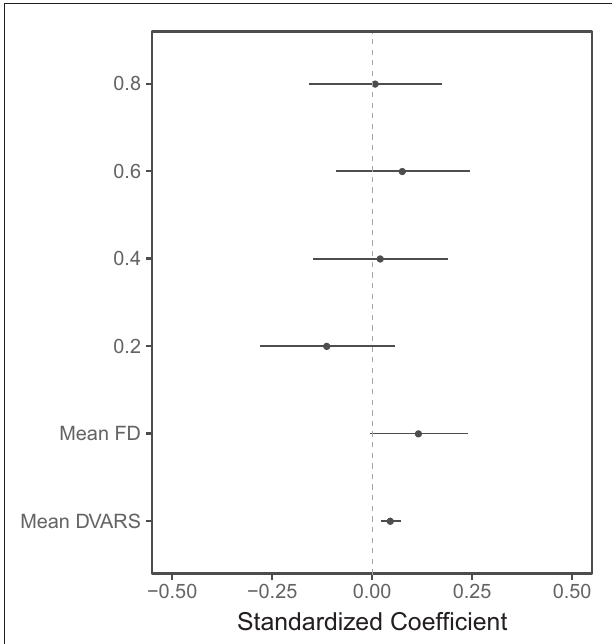
FIGURE 4 | Visualization of the results of the linear mixed model of the association between several predictors and BOLD delay lesion volumes. The points represent the standardized (beta) coefficients and the lines represent the 95% confidence intervals of the coefficients for each predictor. FD: framewise displacement. The scan lengths are shown as 0.8, 0.6, 0.4, and 0.2 with the full scan used as the reference category. This plot shows that the head motion metrics (mean FD and mean DVARS) are significantly associated with larger BOLD delay lesion volumes. There is no statistically significant difference between BOLD delay lesion volumes derived from the shorter resting-state functional MRI scans and the full scan. Note that only a subset of the predictors in this model are shown here—the numerical results of this linear mixed model, including the rest of the predictors, are shown in Supplementary Table 1